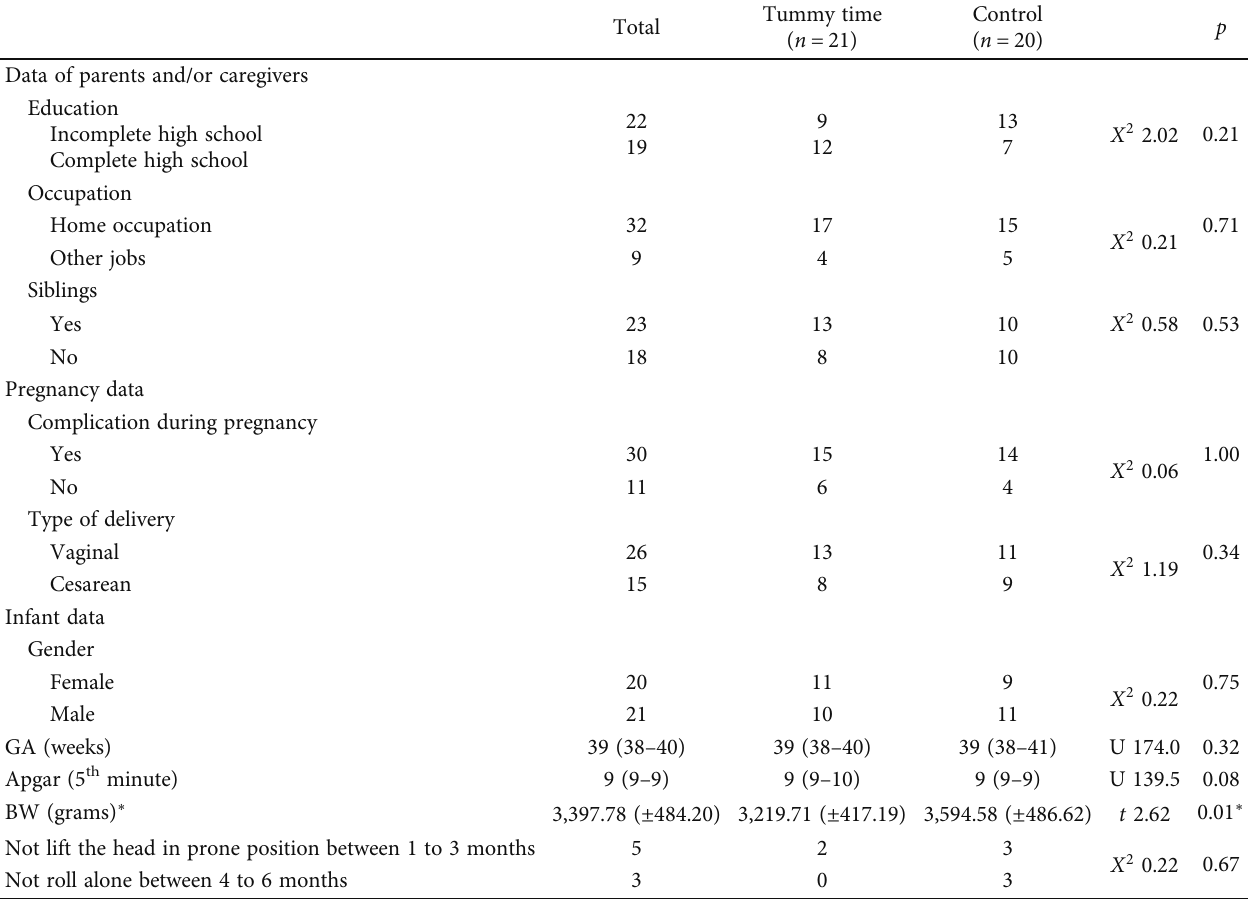
Table 1: Characterization of infants ( n = 41